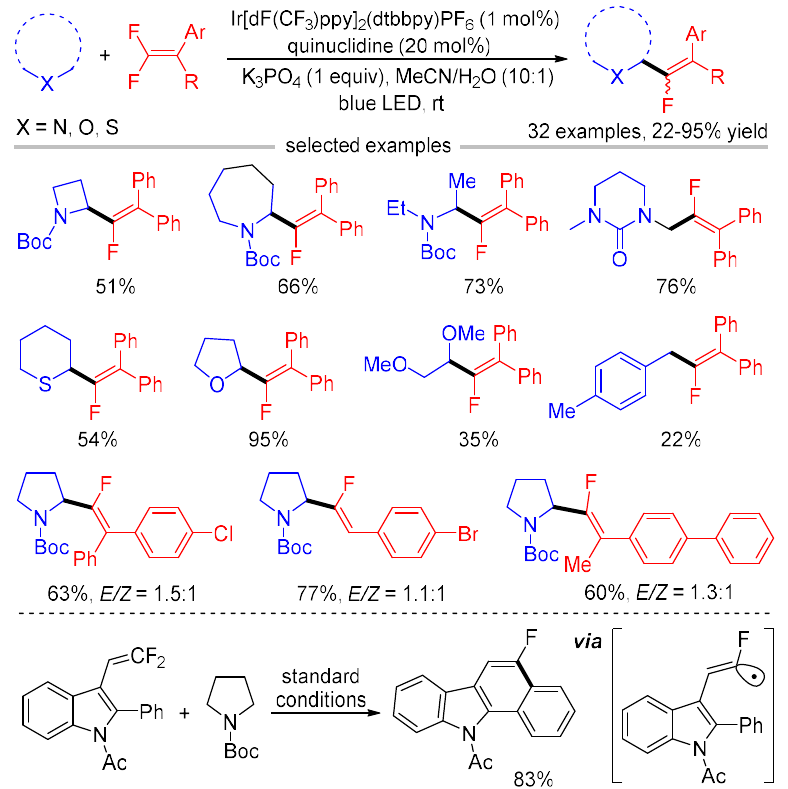
Scheme 12. Monofluoroalkenylation of inert C(sp 3 )–H bonds via HAT.